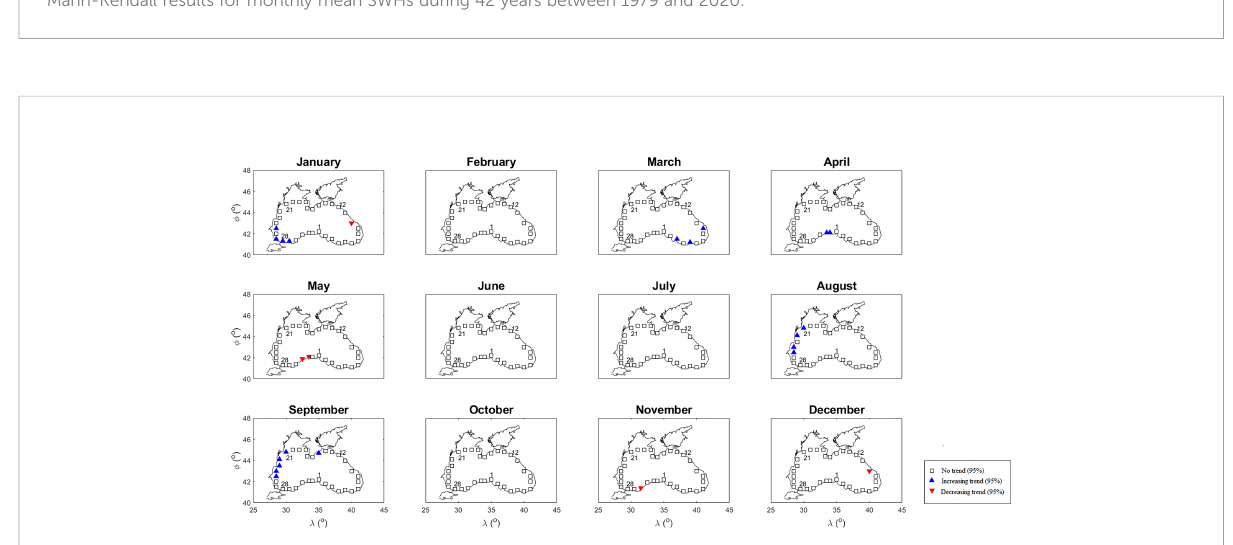
FIGURE 3 Mann-Kendall results for monthly maximum SWHs during 42 years between 1979 and 2020.